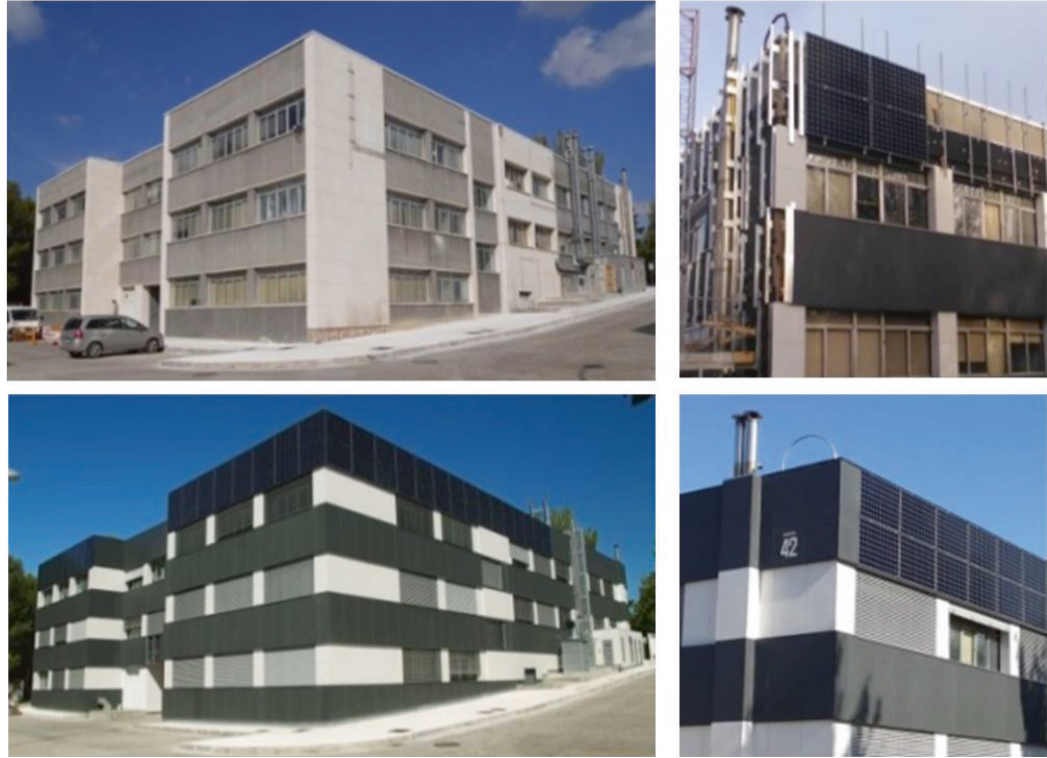
Figure 1: Southeast view of building 42 before and after rehabilitation of the shell. (BIPV) © CIEMAT.